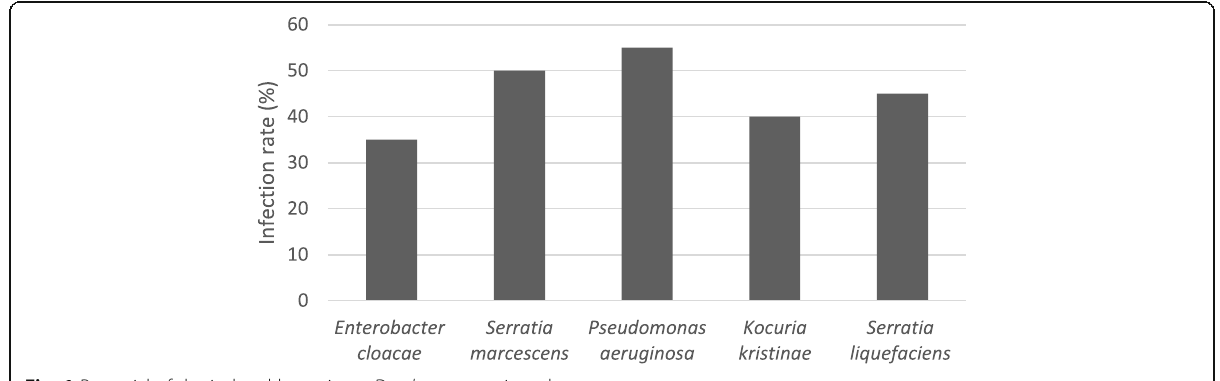
Fig. 1 Potential of the isolated bacteria on Dendroctonus micans larvae